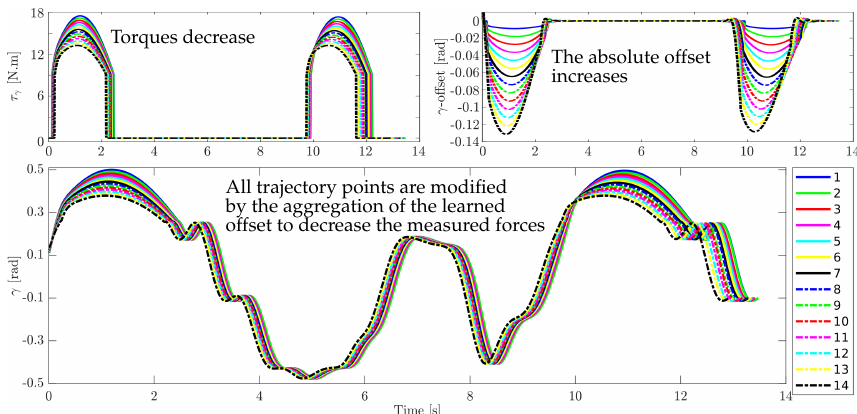
Figure 8. Adaptation of torques of the proposed framework after 14 trials. Top-right shows torques Figure 9. Adaptation of torques of the proposed framework after 14 trials. Top-right : shows torques decreasing from Line -1 to Line -14. Top-left represents the learned offsets and increases throughout the decreasing from Line -1 to Line -14. Top-left : represents the learned offsets and increases throughout the trials. Bottom shows adaptation of the exercise trajectory after 14 trials. trials. Bottom : shows adaptation of the exercise trajectory after 14 trials.